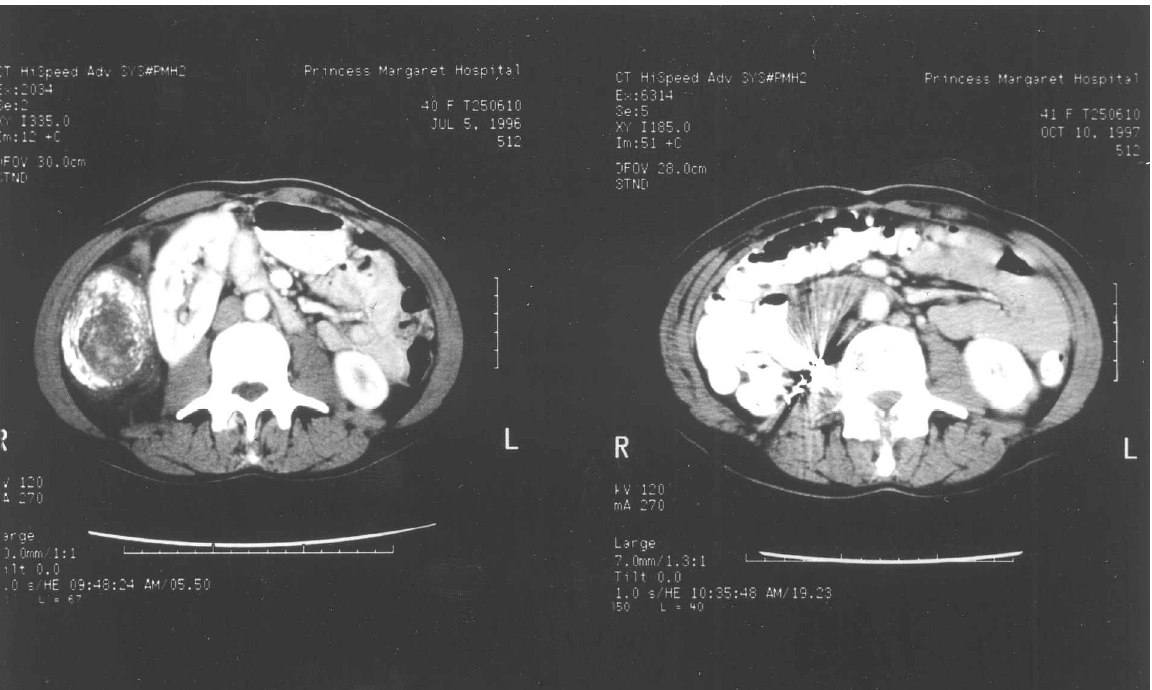
Fig. 5. Comparison of the radiation field pre- and post-operatively. Pre- and post-operative CT scans of a patient with a right-sided RPS are shown in the left- and right-hand panels, respectively. The post-operative film demonstrates that the previously displaced bowel has fallen back into the tumour bed after resection of the tumour and right